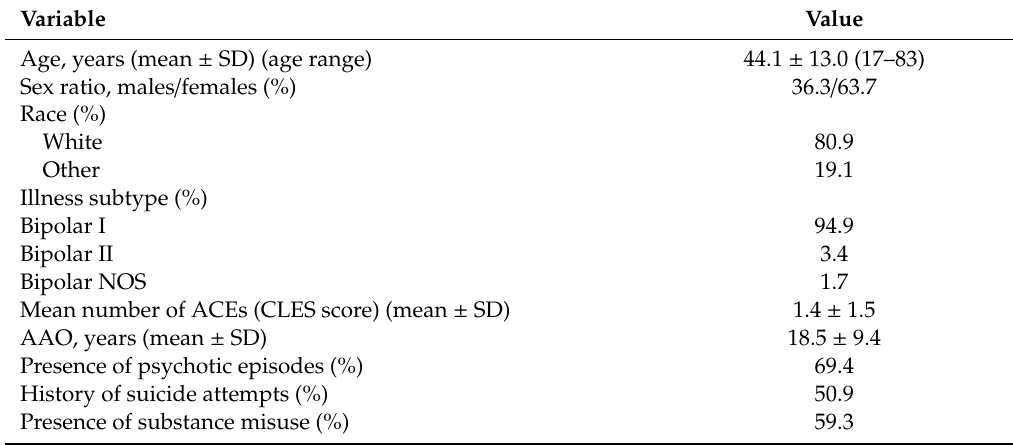
Table 2. Demographic and clinical characteristics of patients with bipolar disorder (BD) ( N =